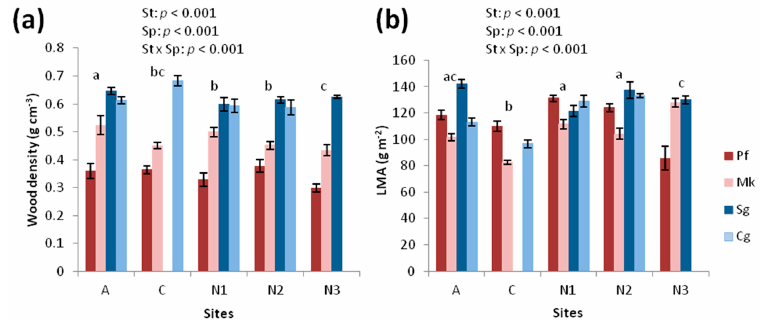
Figure 5. Leaf structural traits, wood density ( a ), and leaf mass per area (LMA; ( b )) of four species (Sp) at five sites (St) along an elevation gradient. Significant overall differences among sites are indicated by different letters above the bars of each site. Explanations of site abbreviations and species names are provided in Table 1 and Figure 1, respectively; the site order follows increasing elevation from left to right.